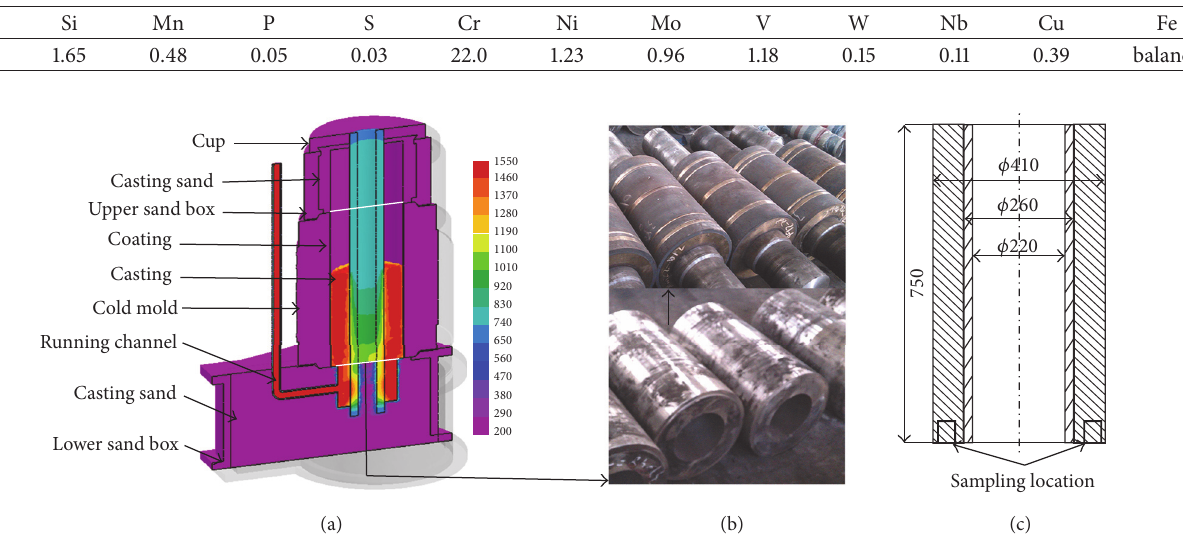
Figure 1: The schematic representation (a) and the actual picture and (b) the design parameters of roll sleeve